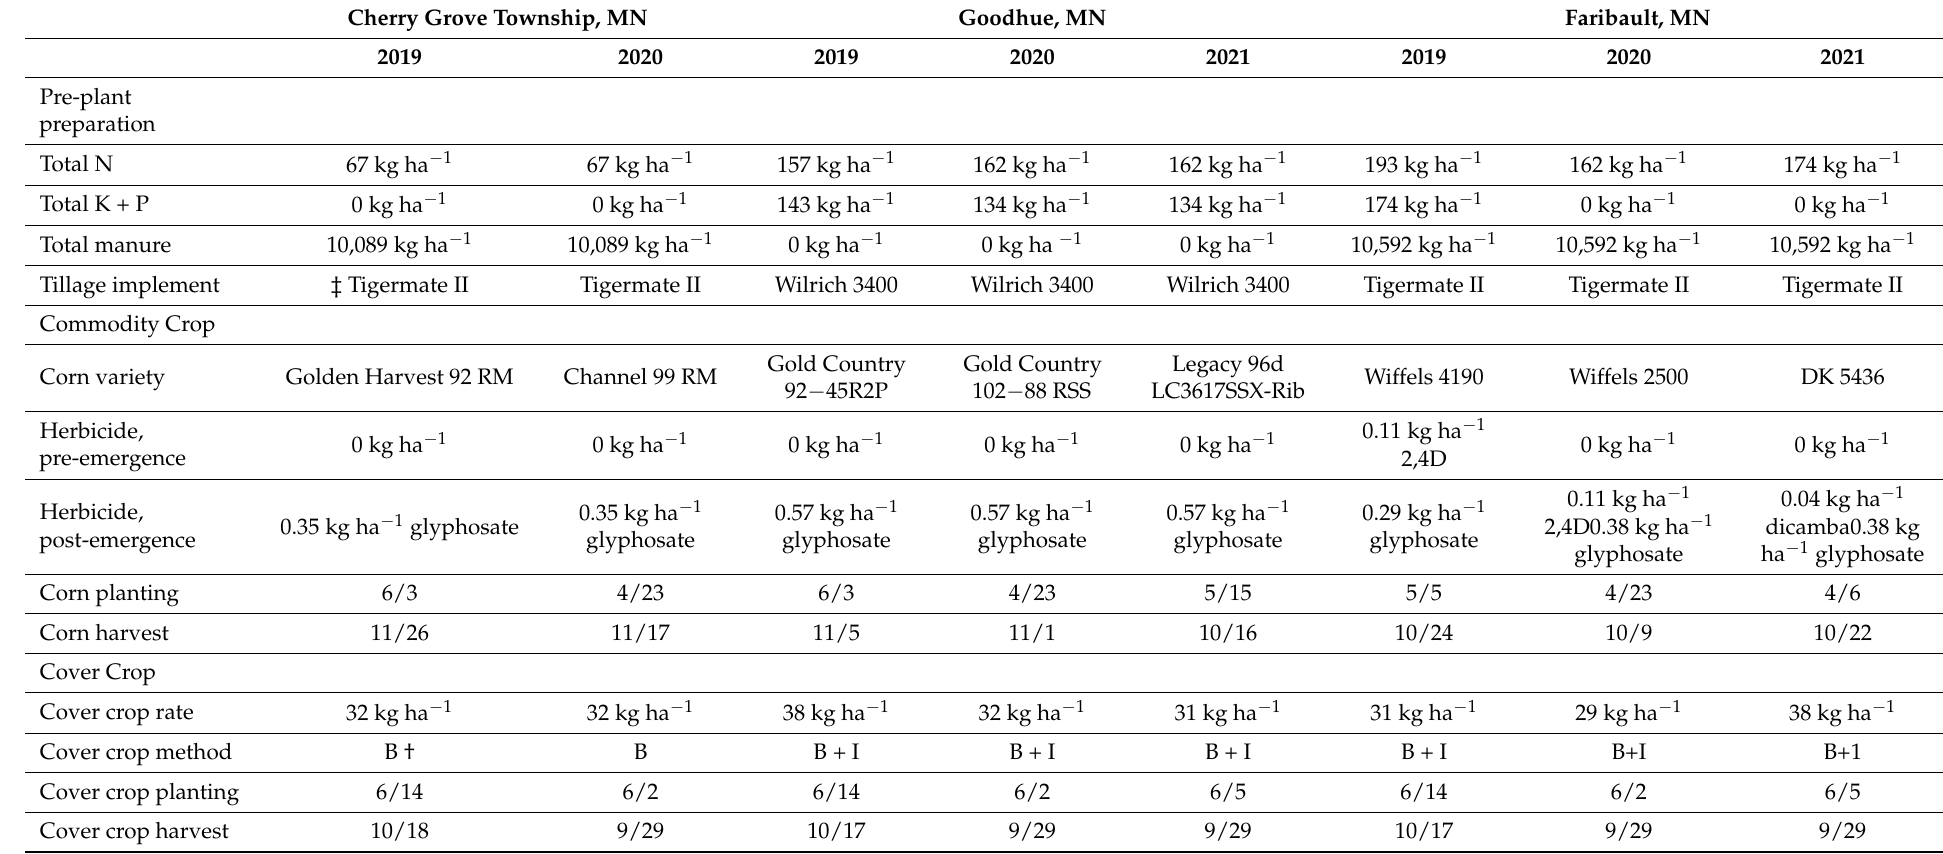
Table 3. Field operations and pre-site preparation of the experimental sites across three locations from 2019–2021 in the Goodhue and Rice Counties, MN,